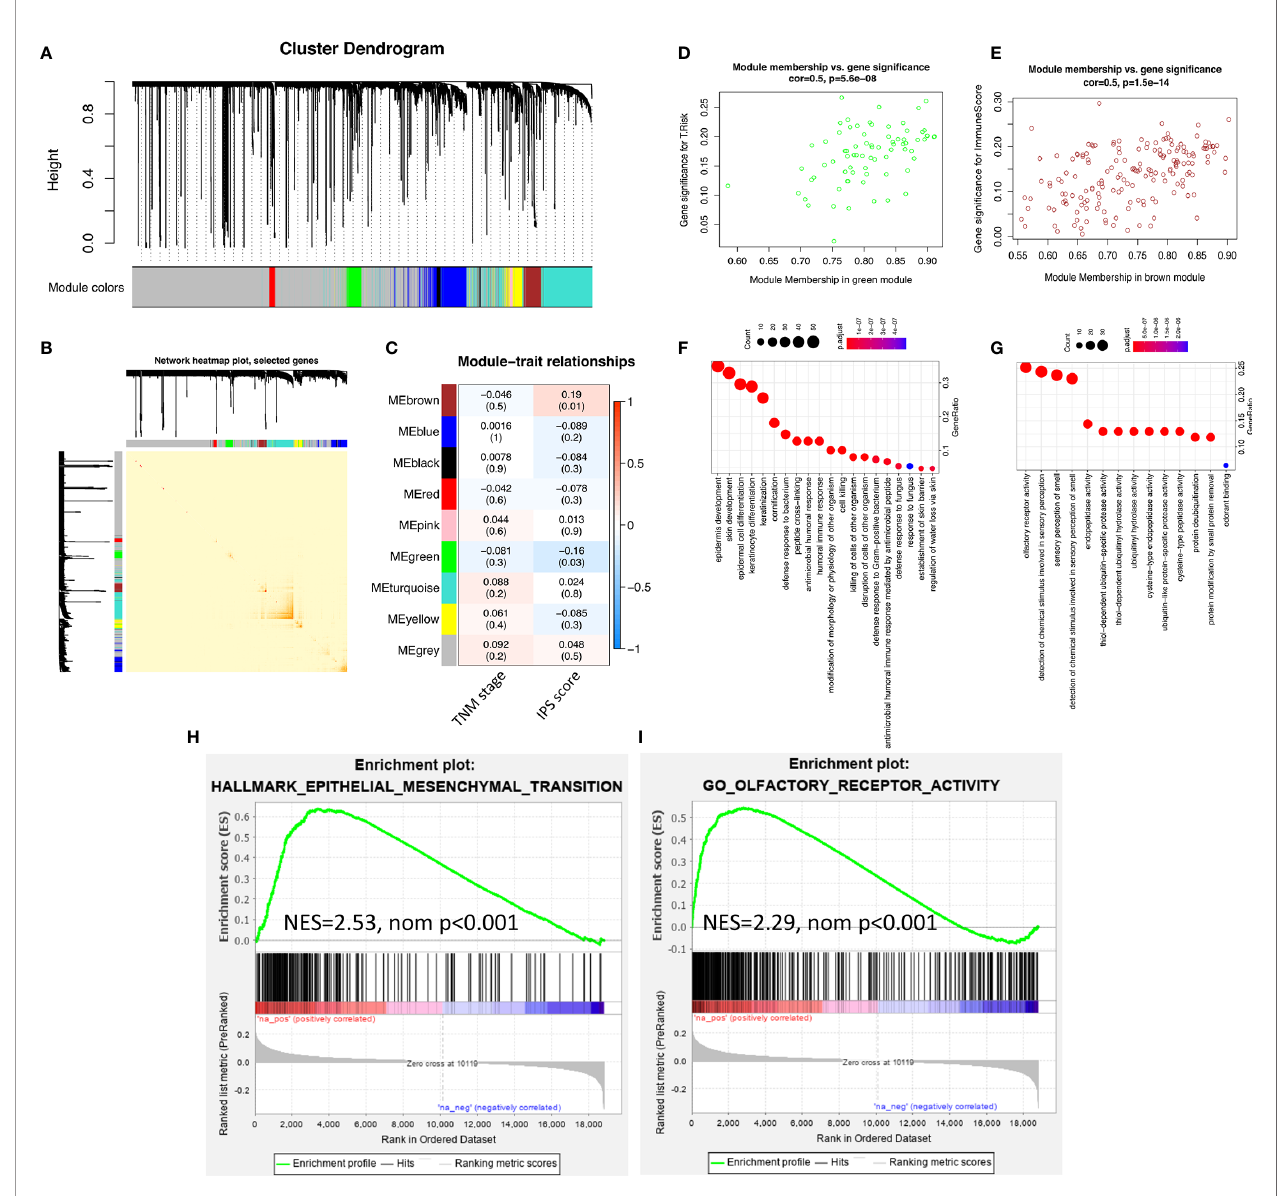
FIGURE 3 | EMT processes were identi fi ed in the mechanistic study of the survival-predictive effect of the IPS. (A) Nine gene coexpression modules were identi fi ed by unsupervised clustering in the WGCNA. (B) Interaction relationship analysis of coexpressed genes showed a high-scale independence degree among the nine identi fi ed modules in the WGCNA. (C) Heatmap of the correlation between module eigengenes and the disease TNM stage and IPS score. (D, E) Scatter plots of module eigengenes in the green and brown modules. (F, G) Results for the GO annotation of genes in green and brown modules. (H, I) GSEA con fi rmed that pathways related to the EMT process were enriched in green module genes, and olfactory receptor activity pathways were enriched in brown module